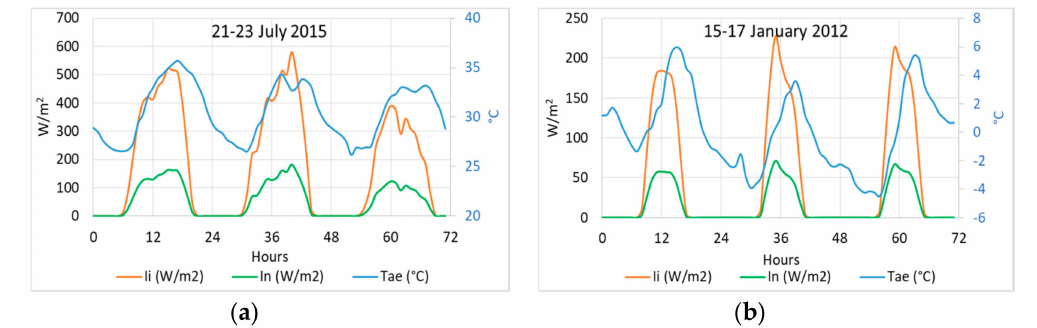
Figure 13. Hourly values of global solar radiation ( I i ) , solar radiation entering in the system ( I n ), and the external air temperature ( T ae ) for three consecutive days: ( a ) 21–23 July 2015; ( b ) 15–17 January 2012.